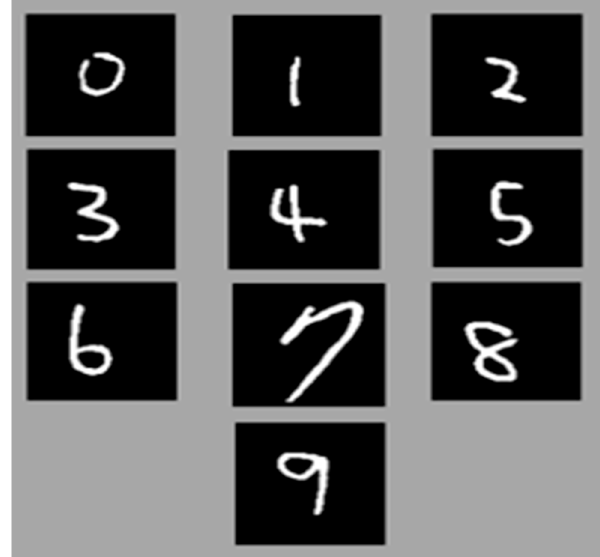
Figure 14. Numbers in the handwritten dataset .